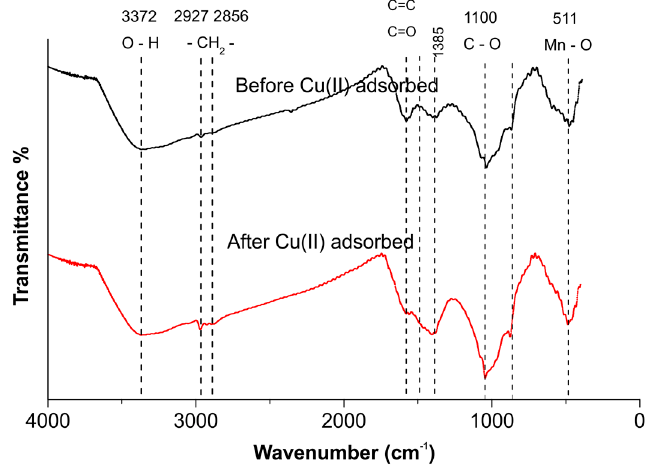
Figure 8. FTIR spectra of NMBCs before and after Cu(II) adsorption.